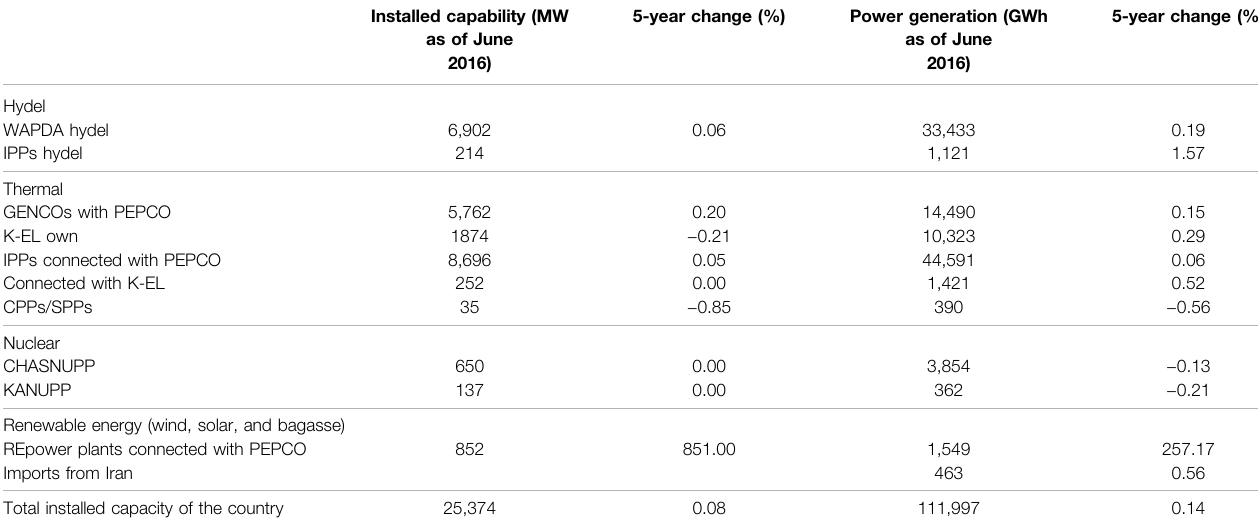
TABLE 3 | Built power production in MW and electrical power in GWh by form.